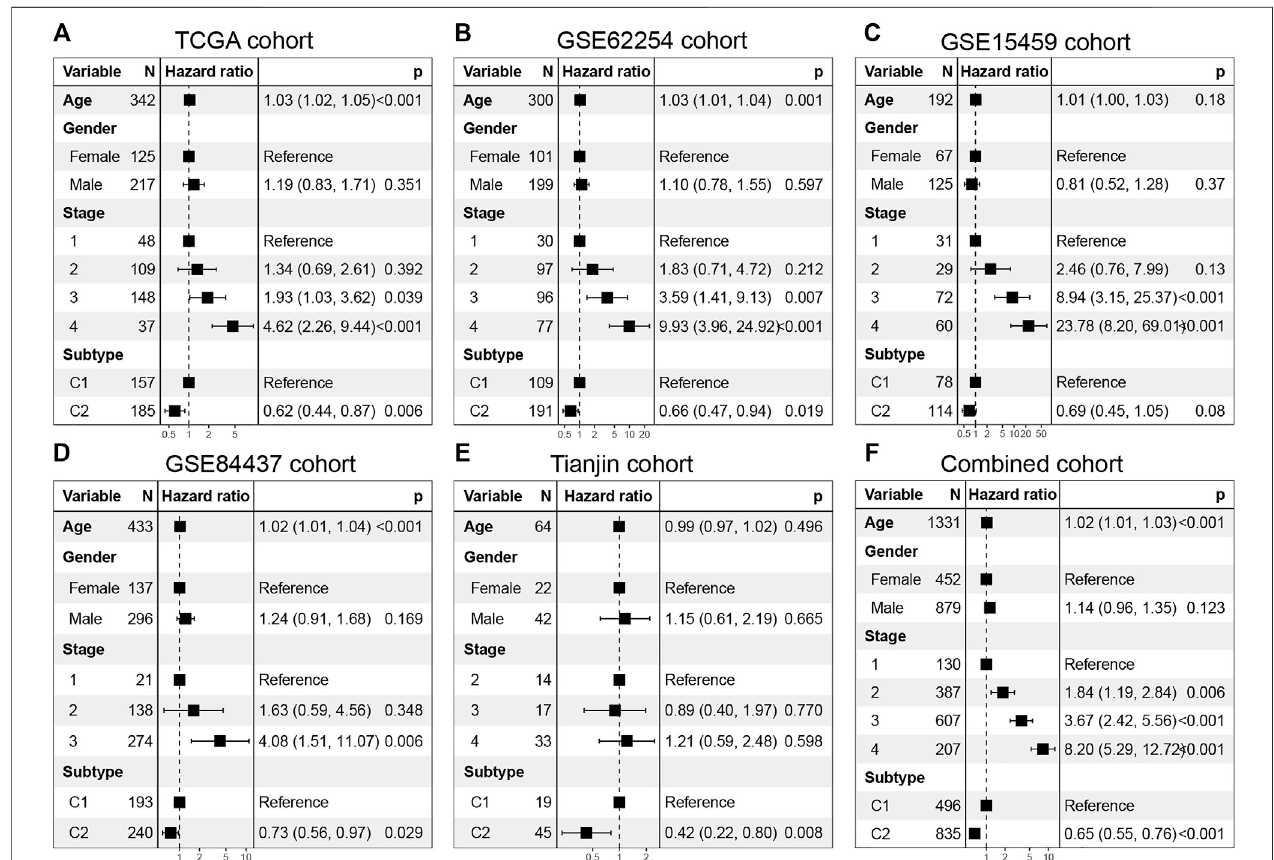
FIGURE 5 | Multivarate Cox regression analysis of C1/C2 subtype in (A) TCGA cohort, (B) GSE62254 cohort, (C) GSE15459 cohort, (D) GSE84437 cohort, (E) Tianjin cohort and (F) Combined cohort. Multivariable Cox regression analysis was used to evaluate independent prognostic factors associated with overall survival, including age, gender, and tumor stage. A p value of less than 0.05 was considered statistically signi fi cant.